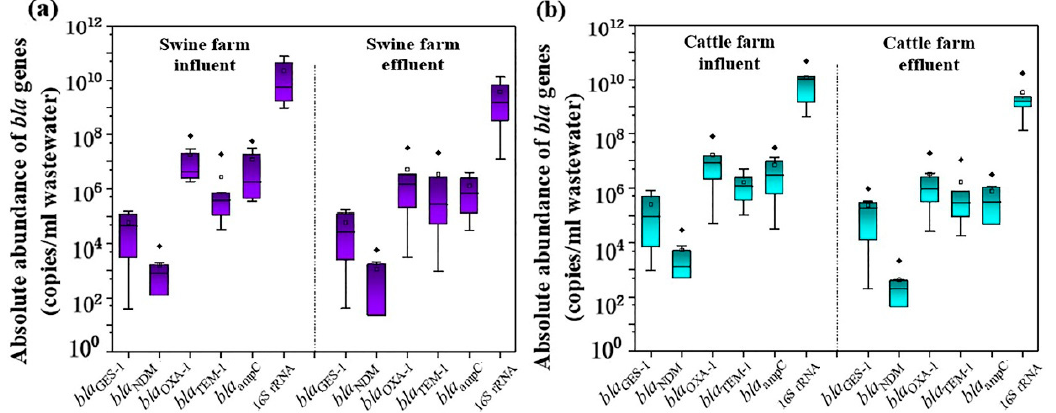
Figure 3. Absolute abundance of bla genes in livestock wastewater from family swine farms ( a ) and family cattle farms ( b ). Solid points represent extreme outliers, that is, outliers more than three times the quartile distance; Hollow points represent milder outliers, that is, outliers between 1.5 and 3 times quartiles.